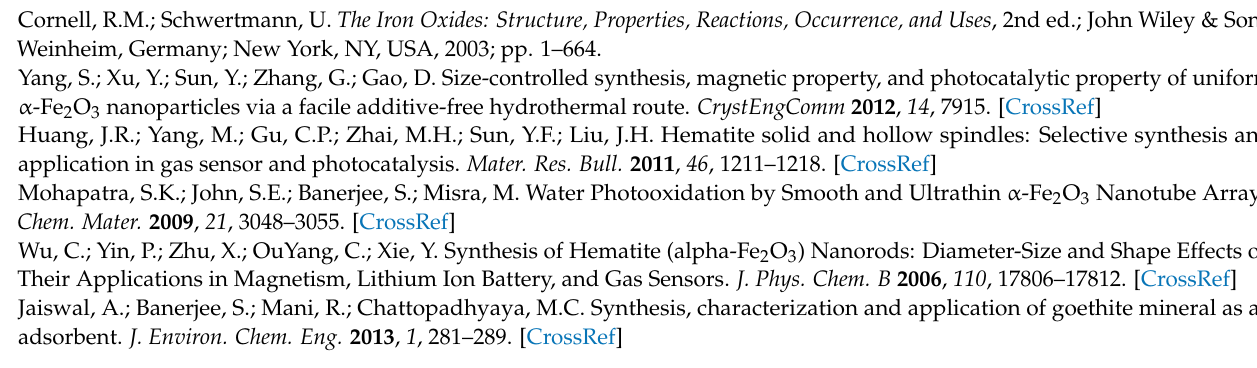
Supplementary Table S1. Mössbauer parameters for reference samples and samples with PEG